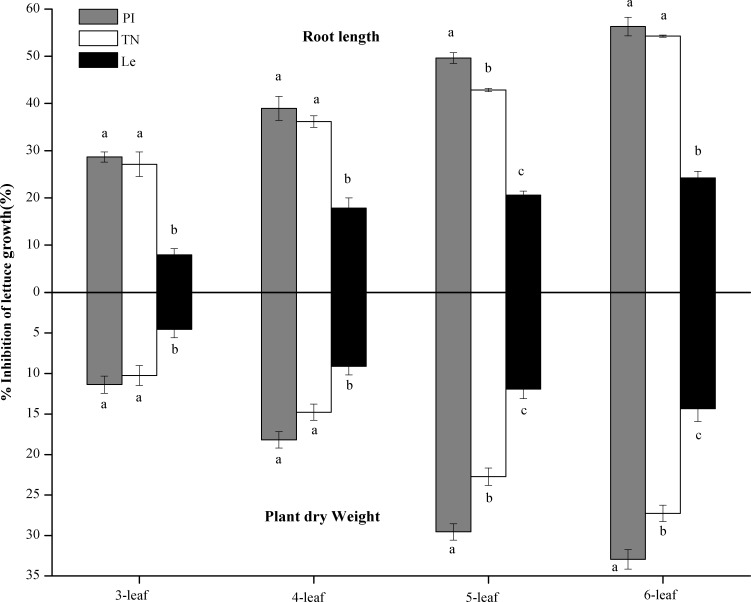
The % inhibition of the root exudates of the three rice cultivars (PI and TN, allelopathic cultivars PI312777 and Taichung Native1; Le, non-allelopathic cultivar Lemont) at 3–6 leaf stages.Significant differences (P < 0.05) between rice cultivars at the same leaf stage were indicated by different lowercases, according to Tukey’s honestly test.